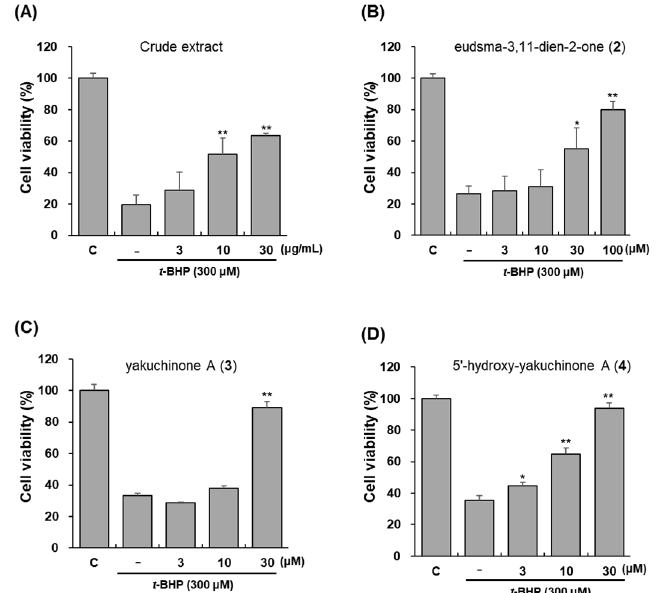
Figure 5. Protection against t -BHP-induced toxicity of total extract ( A ) and pure compounds 2 – 4 ( B – D ) from A . oxyphylla . HepG2-ARE cells were pre-treated with each compound (3, 10, 30, or 100 μ M) for 12 h and added t -BHP (300 μ M) for 4 h. Data are presented as the mean ± S.D. ( n = 3). * p < 0.05, ** p < 0.01 (compared with the vehicle-treated control).